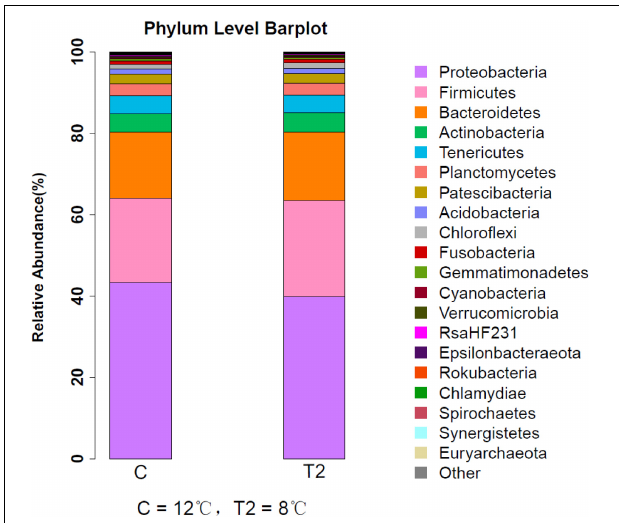
FIGURE 3 | Relative abundance of intestinal microbiota in large yellow croaker by phylum. C represents the control group where the fish were kept at 12 ◦ C at the beginning of the experiment and T2 represents the group where the fish were kept at 8 ◦ C for 3 days.